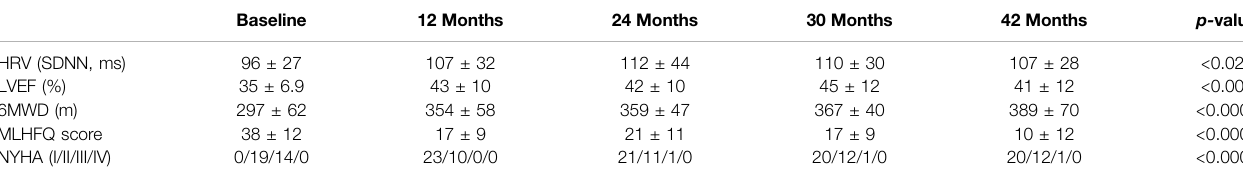
TABLE 6 | Ef fi cacy measures at 42 months in cohort study of ANTHEM-HF patient population (n = 33).